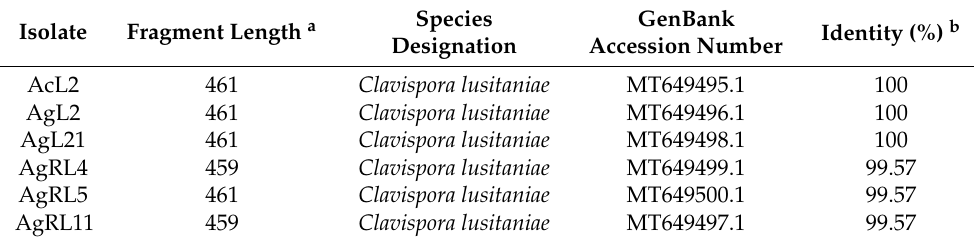
Table 1. Identification of the yeast species of the six best isolates. Isolate